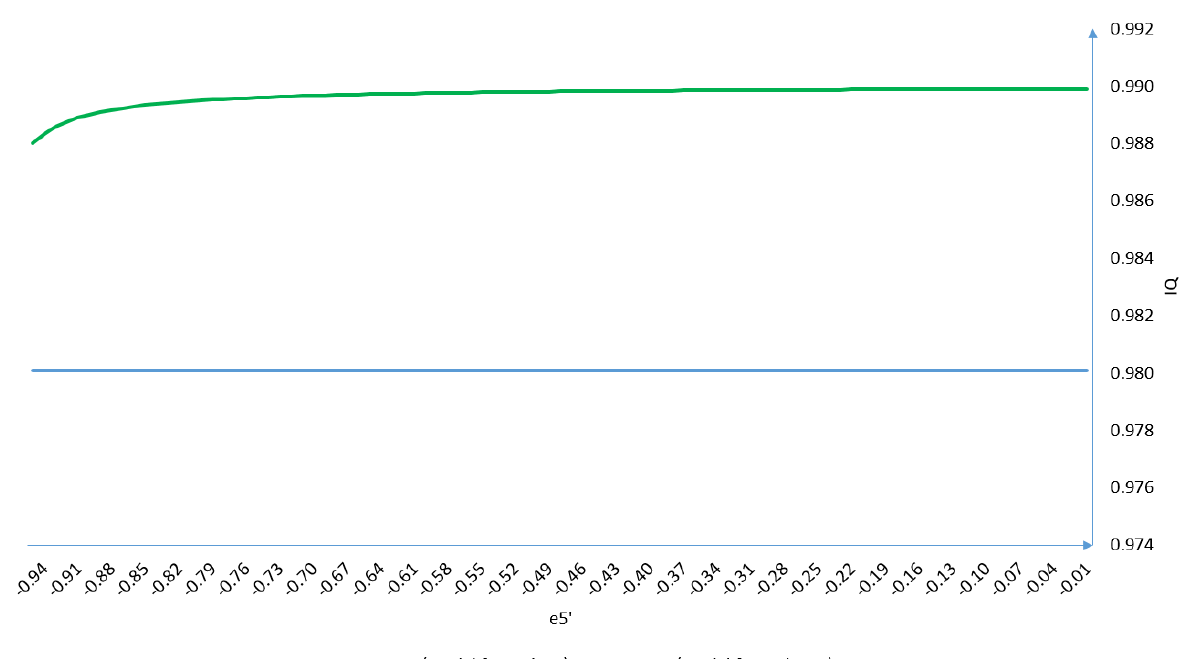
Figure 14. The result of simulating the impact of observation coefficient values for models from